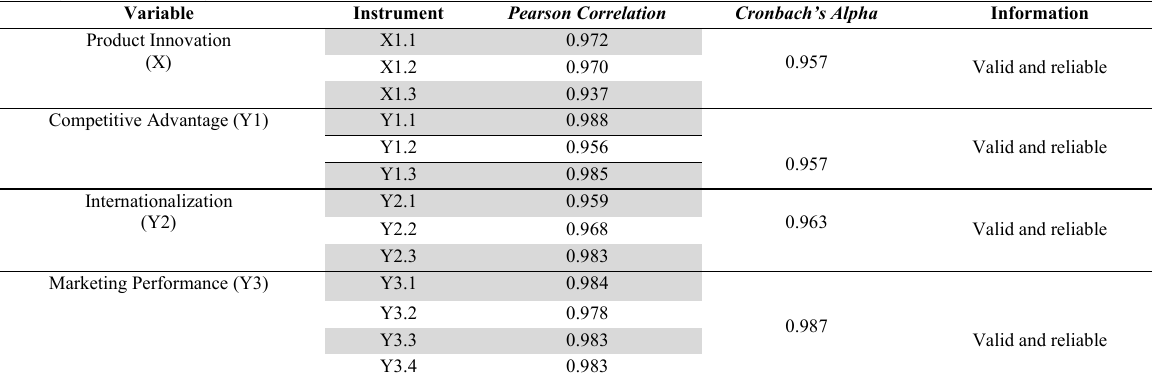
Validity and Reliability Test